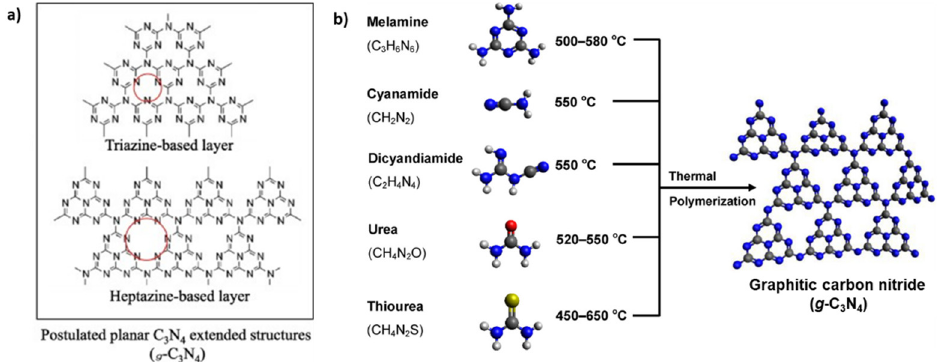
Figure 3. ( a ) Structure of graphitic carbon nitride g -C 3 N 4 . Reproduced from [46]. Copyright 2019, Elsevier. ( b ) Schematic diagram of g -C 3 N 4 synthesis by thermal polymerization from various precursors (thiourea, melamine, cyanamides, dicyanamide, and urea). Reproduced from [47]. Copyright 2016, ACS Publications.